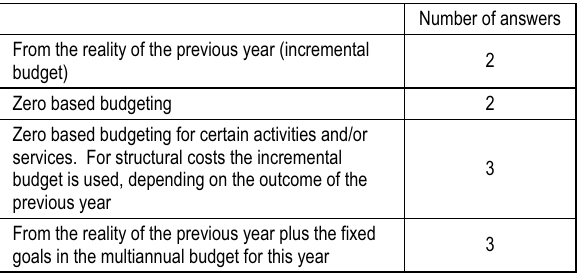
Table 10. Answer to the question: starting point of the budget preparation